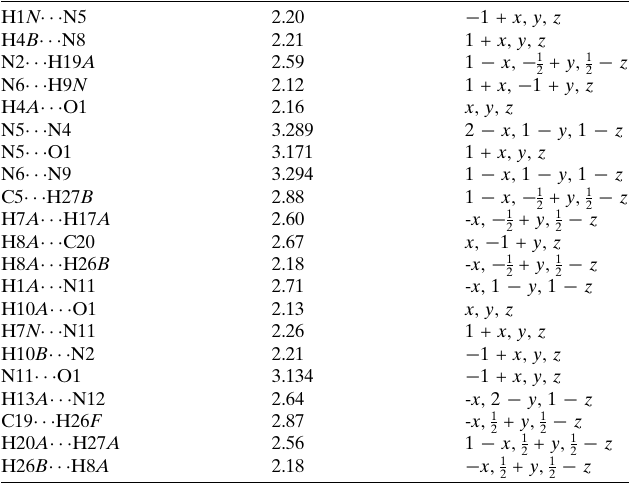
Table 2 Summary of short interatomic contacts (A˚ ) in the title compound. H1 N (cid:2)(cid:2)(cid:2)